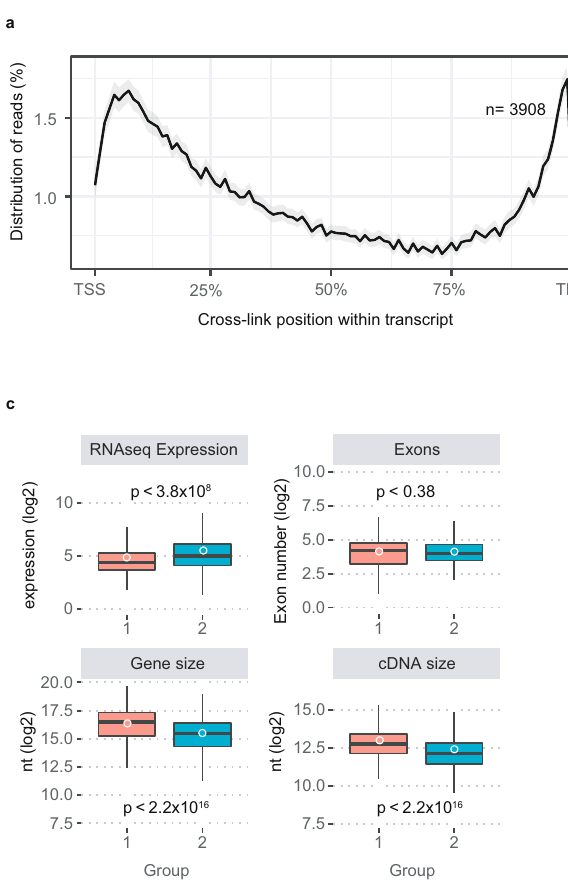
Fig. 4 | Transcript features dictate different ALYREF anchoring pro fi les. a Average distribution plot of ALYREF cross-link sites across all TU ’ s. TU ’ s were normalised for length and expressing transcripts above 200nt. Data represent the average of two biological replicates, with con fi dence intervals shown as a grey ribbon.ThenumberofTUsusedforpro fi lingisindicated. b Asin a butstrati fi edby gene groups identi fi ed by k-means clustering analysis (Supplementary Fig. 4a). c Boxplots indicating the median (middle line), fi rst and third quartiles (box), ±1.5×interquartile range (whiskers) and the sample mean (white circle) of RNAseq